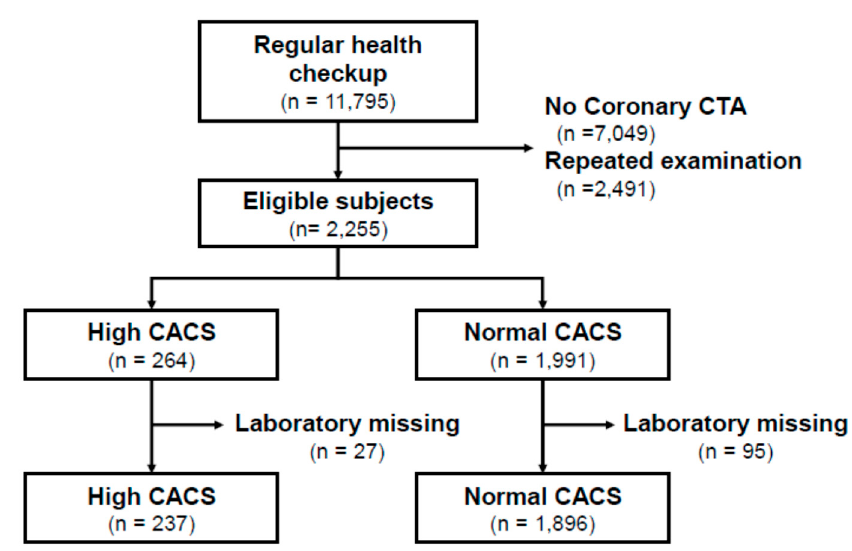
Figure 1. Flow chart of the participants. CTA, Computed tomography angiography; CACS, coronary artery calcium score.